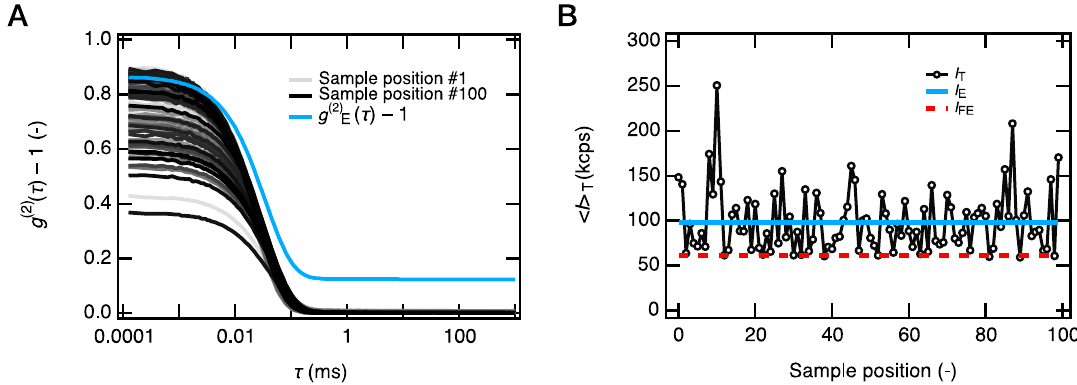
Figure 5. Spatial heterogeneity in a length scale of light scattering. The measurements performed at q = 0.00141 Å − 1 . ( A ) DLS intensity correlation functions ( g (2) ( τ ) − 1) at 100 randomly chosen sample positions and the ensemble-averaged correlation function ( g (2) E ( τ ) − 1). ( B ) Time-averaged scattering intensity at the 100 sample positions, i.e., stationary laser speckles. The solid blue line indicates the ensemble-averaged scattering intensity ( I E ), and the dashed red line shows the time fluctuating component ( I FE ) of I E